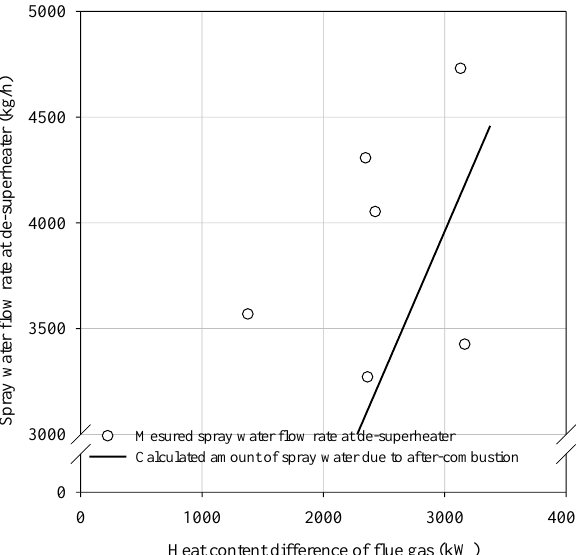
Figure 6. A comparison of the calculated spray water flow rate by convection pass inlet temperature and measured flow rate of spray water at de-superheater.